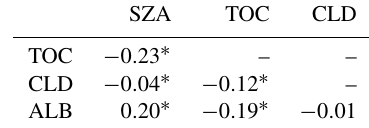
Table 1. Intercorrelation of explanatory variables (SZA is solar zenith angle, TOC is total ozone column, CLD is cloud cover, ALB is albedo). Statistically significant results ( α = 0.05) are marked with an asterisk. SZA TOC